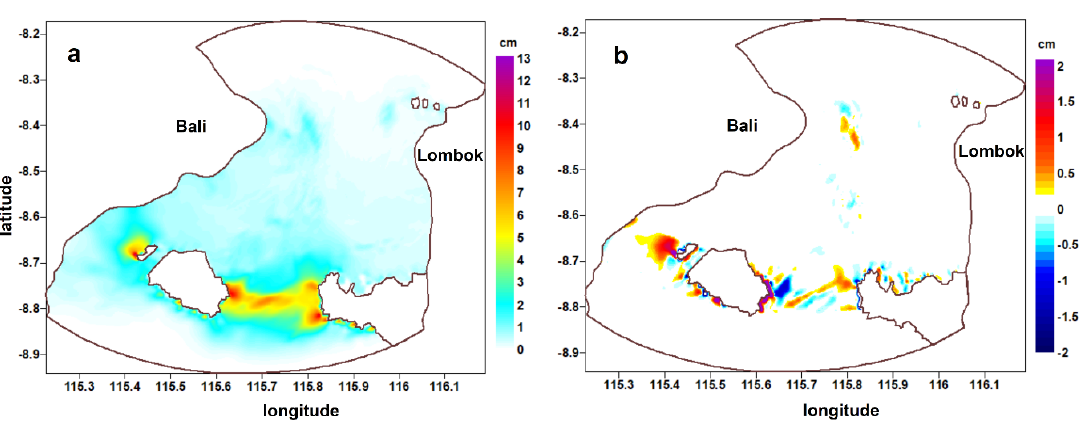
Figure 9. Nonlinearity in the sea surface height. ( a ) Hs approach; ( b ) the difference in the nonlinearity in the sea surface height between Hs and Nh approach.